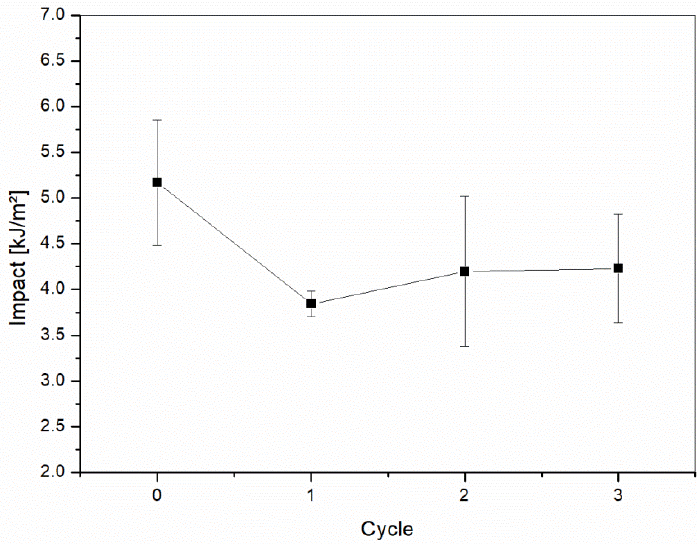
Figure 13. Impact test results of the reinforced H20 blends as a function of the recycling cycle.